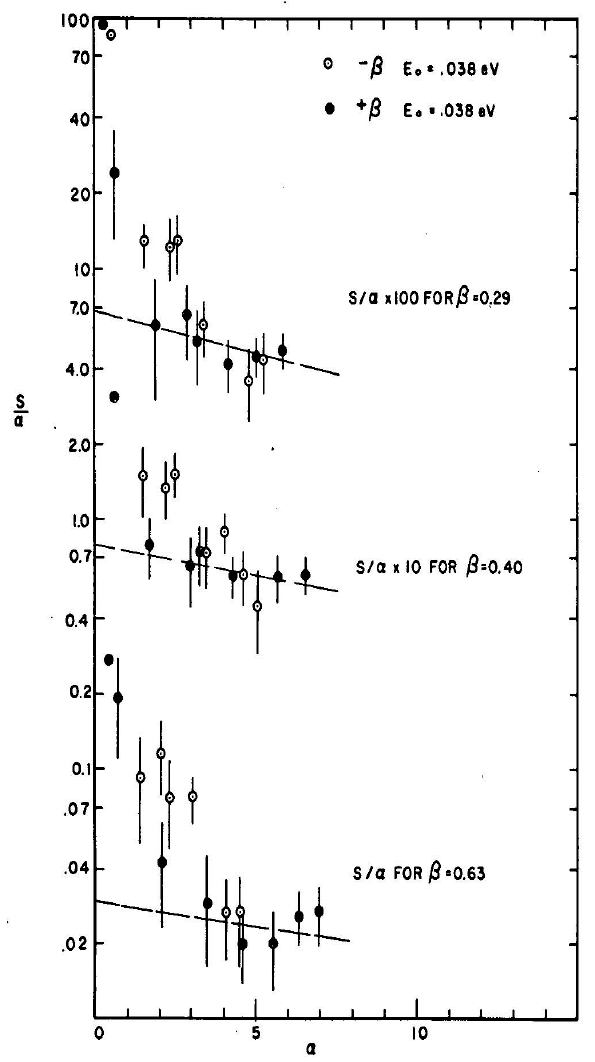
Figure 36. A representation of the scattering law S ( α , β ) for polycrystalline UO 2 at 293 K determined by time-of-flight measurements at Chalk River at three values of β . This figure is taken from Figure 2 of ref. [93] courtesy of the IAEA.